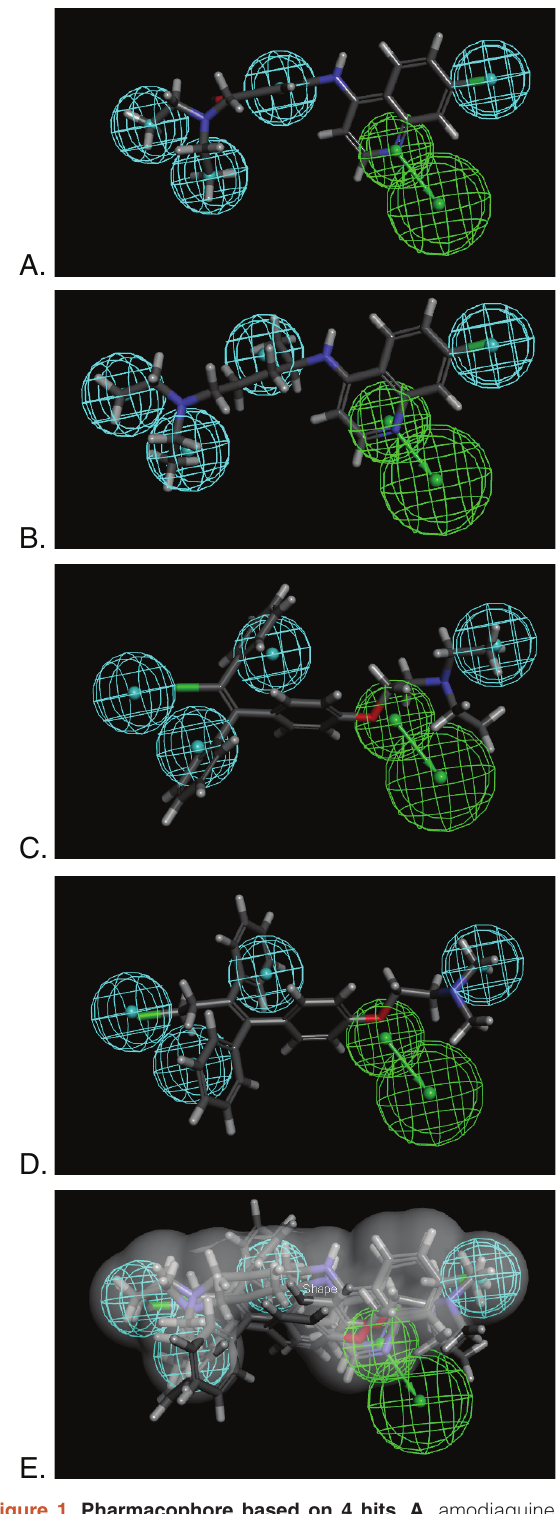
Figure 1. Pharmacophore based on 4 hits. A . amodiaquine, B . chloroquine, C . clomiphene D . toremifene and E . Overlap showing all molecules in the van der Waals surface of amodiaquine. Pharmacophore features are Hydrophobic (H, cyan) and Hydrogen bond acceptor (HBA,